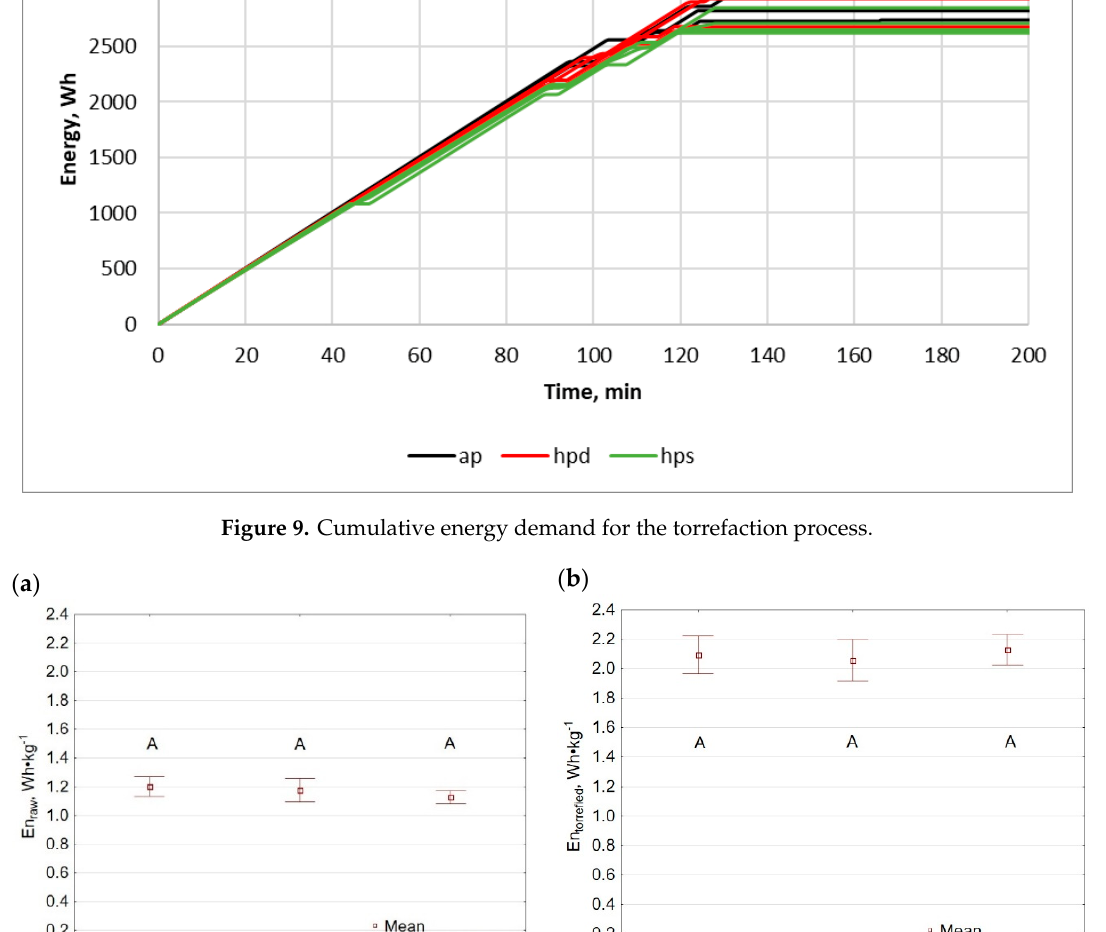
Figure 10. Energy demand to torrefied pellet production, ( a ) energy used to convert 1 kg of the pellet, ( b ) energy needed to produce 1 kg of the torrefied pellet.